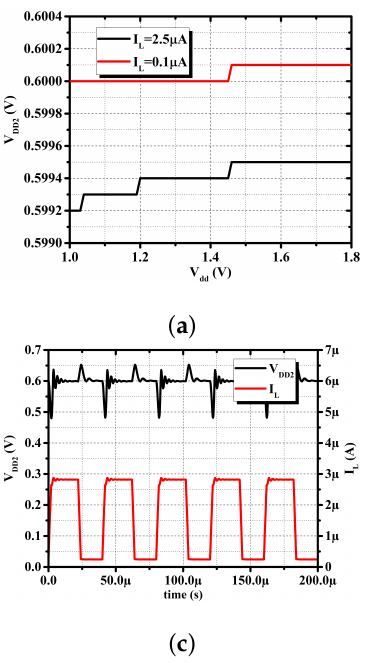
Figure 17. LDO voltage regulator post-layout simulation. ( a ) Line regulation. ( b ) Load regulation. ( c ) Dynamic load regulation.